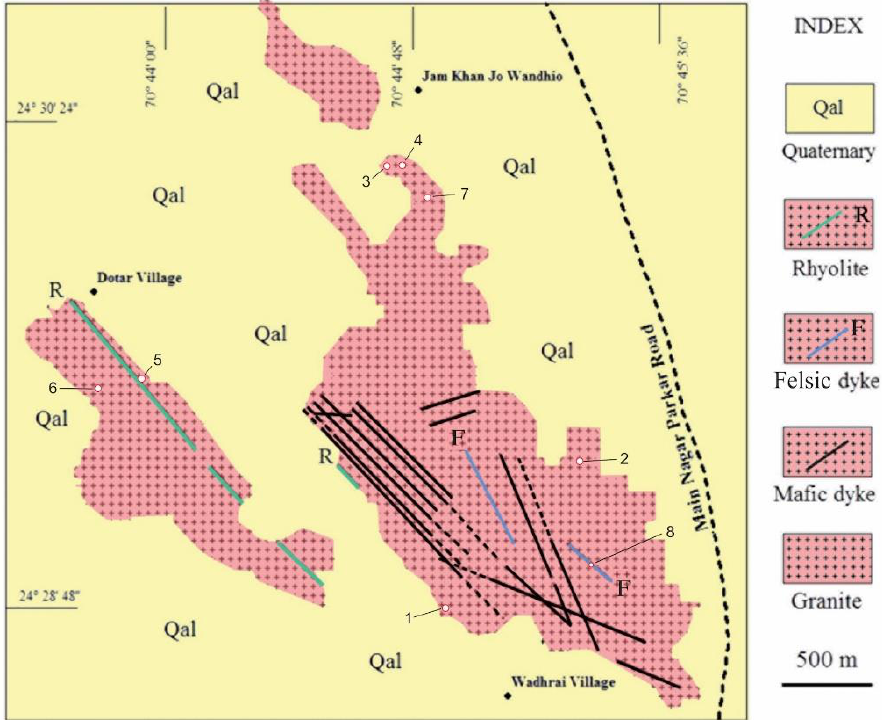
Figure 2. Geological map of the Wadhrai granite stock (modified after [16]. Numbers show the location of the analyzed samples.